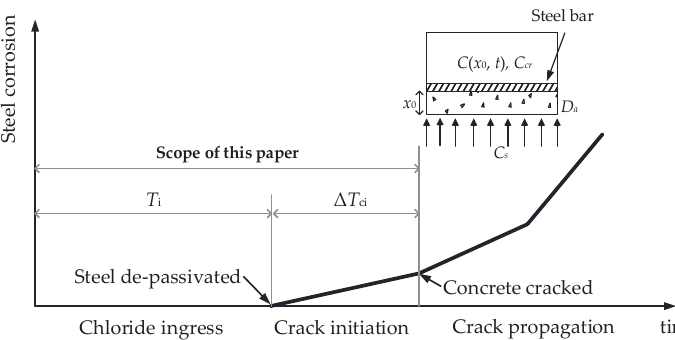
Figure 1. Schematic corrosion-induced deterioration process of RC